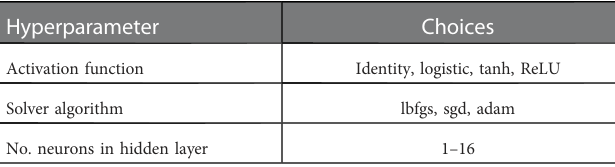
TABLE 2 List of possible choices for each hyperparameter during the grid